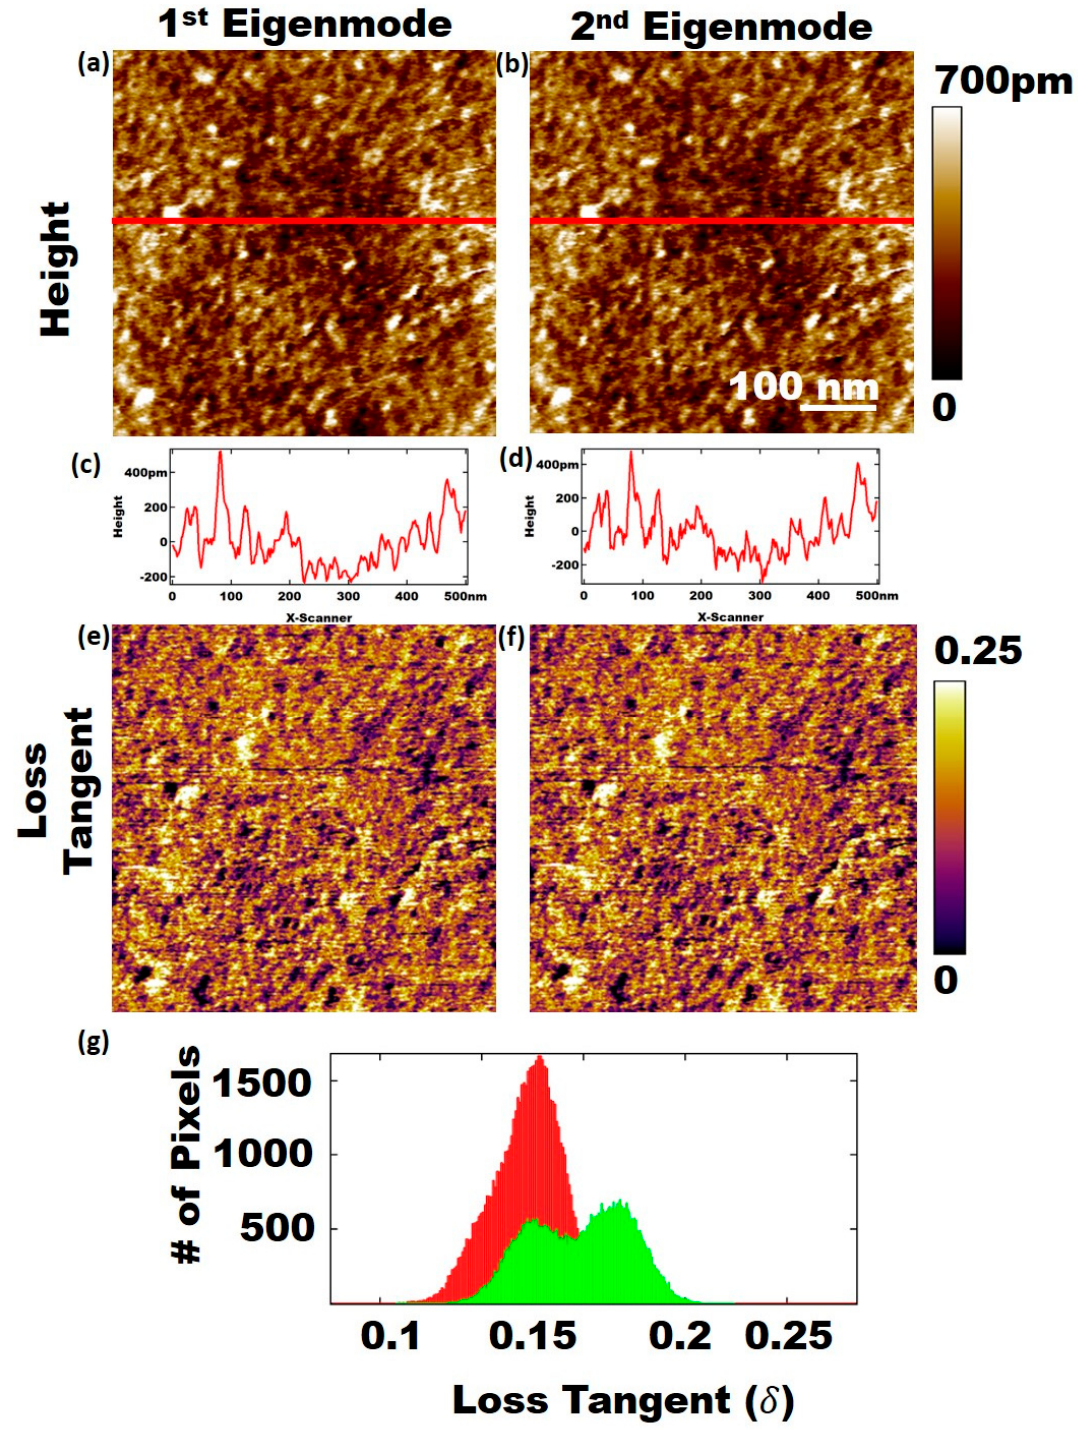
Figure 1. Loss tangent AFM study on Sapphire samples: ( a ) height image using the 1st eigenmode, ( b ) Height image using the 2nd eigenmode, ( c ) topography line of image ( a ), ( d ) topography line of image ( b ), ( e ) loss tangent image using 1st eigenmode, ( f ) loss tangent image done by 2nd eigenmode, and ( g ) histograms of loss tangent. The scale bar is 100 nm. Free first amplitude was 100 nm. Free second amplitude was 20 nm. The setpoint for both of the measurements was 60% to ensure repulsive regime imaging. The first eigenmode frequency was 72 kHz and the second eigenmode frequency was 460 kHz.